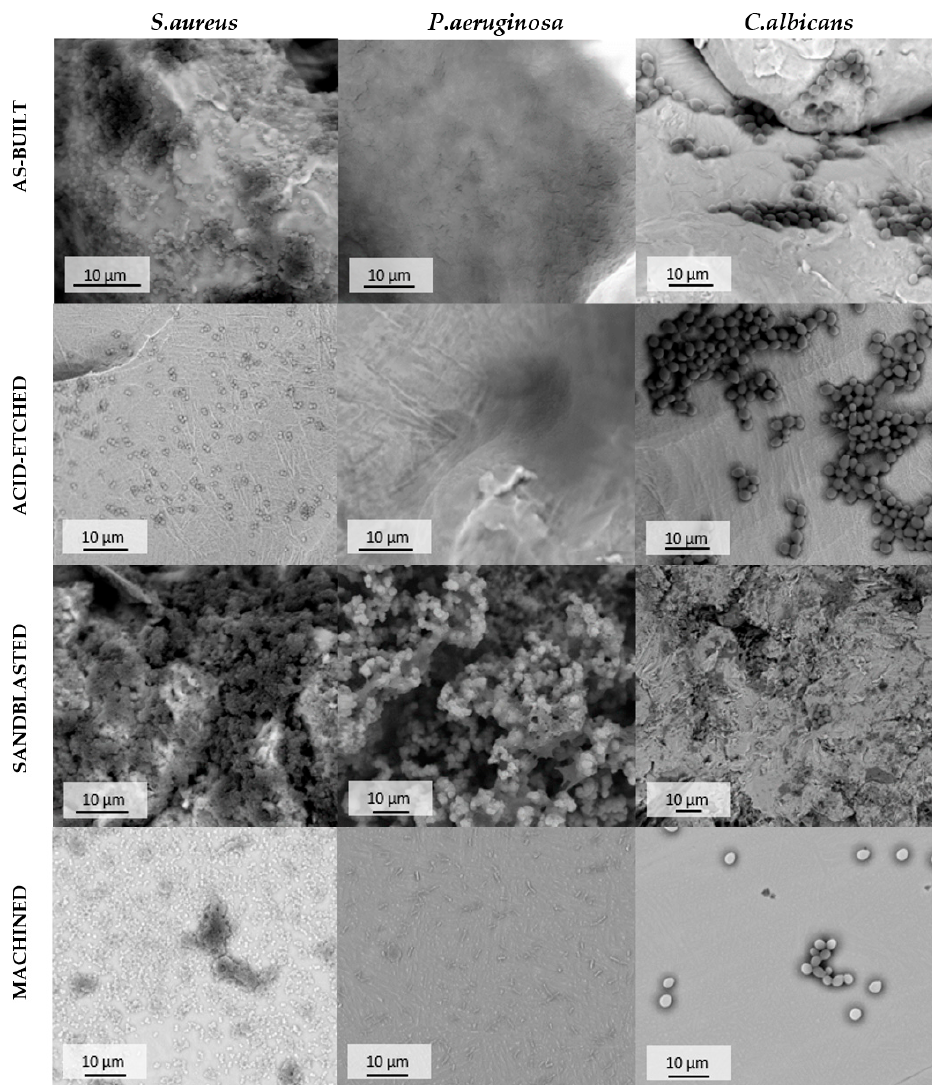
Figure 12. Adhered cells of S. aureus , P. aeruginosa and C. albicans on the surface of